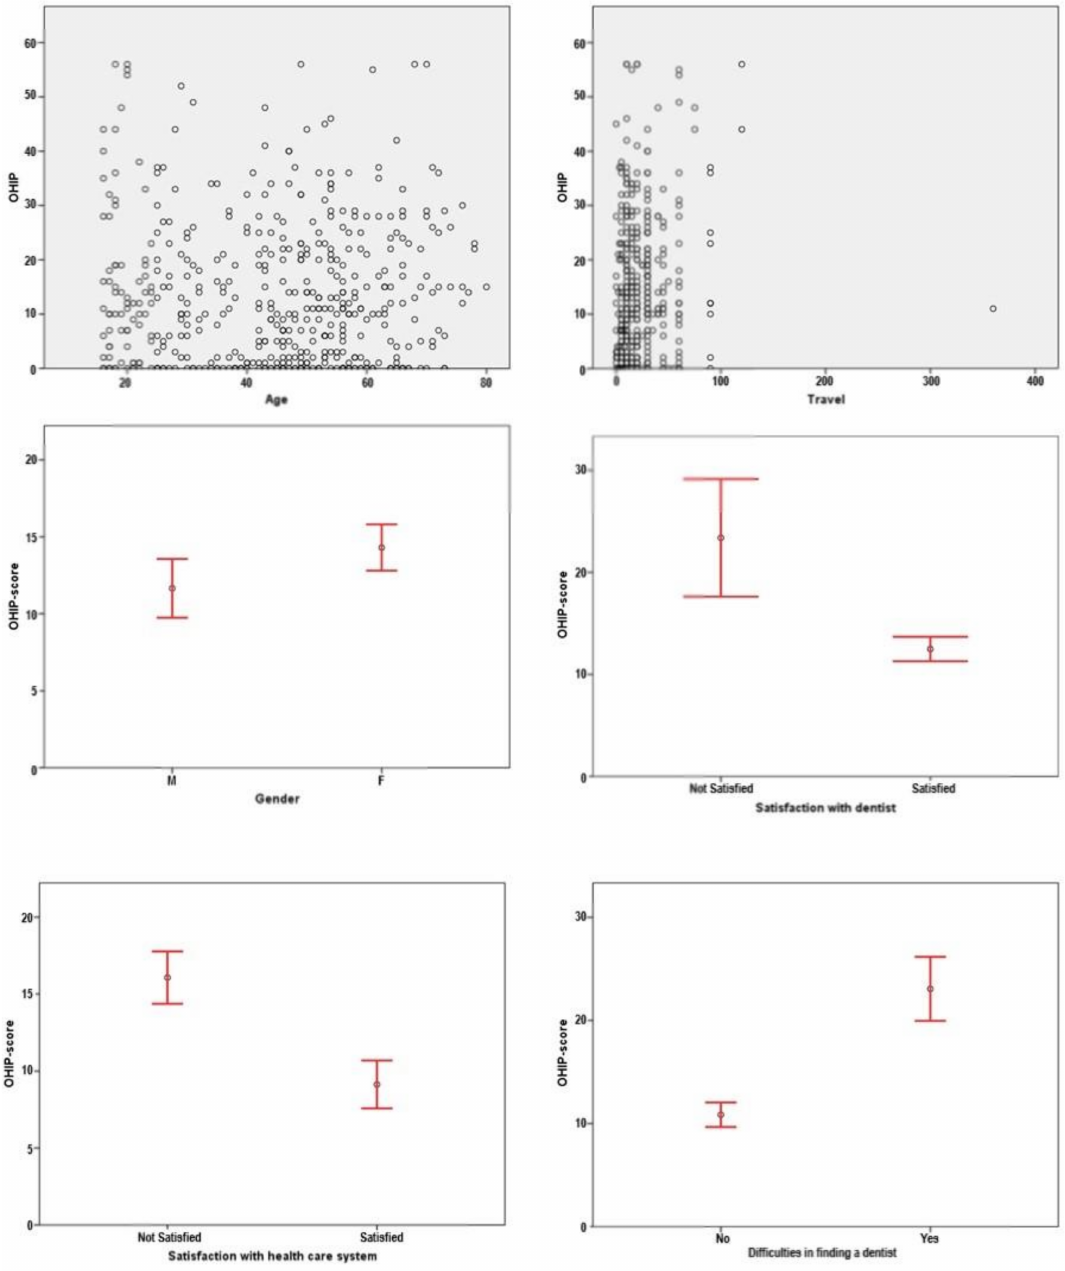
Figure 1. OHIP score according to different